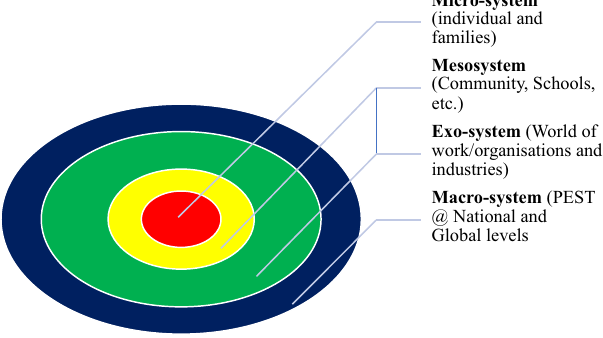
Figure 1. Conceptual